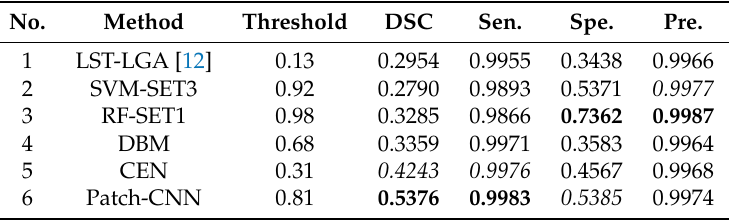
CEN 0.31 0.9968 Patch-CNN 0.81